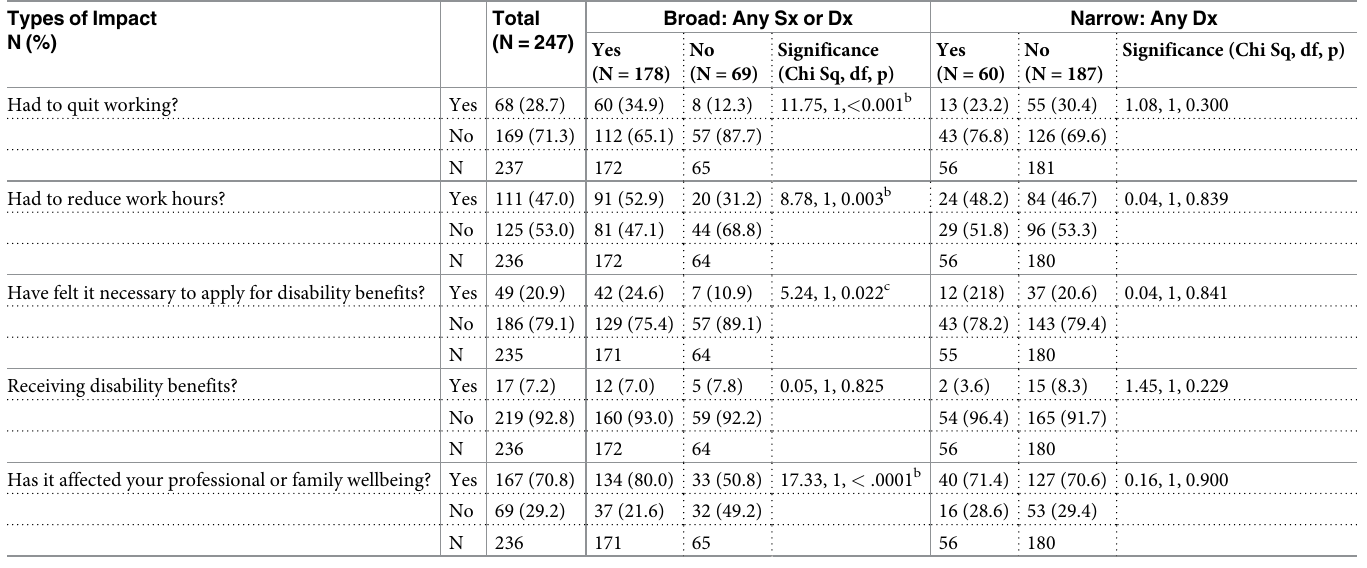
Table 3. The Illness Impact a for ESDS Sample (N = 247). Overall Sample and By Broad and Narrow Definitions of Psychiatric Complaints at Intake b . Types of Impact N